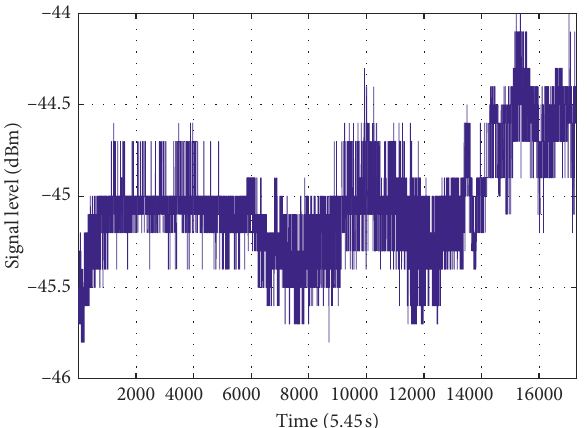
Figure 2: Complex random variation characteristics of the RSL under clear-sky conditions.